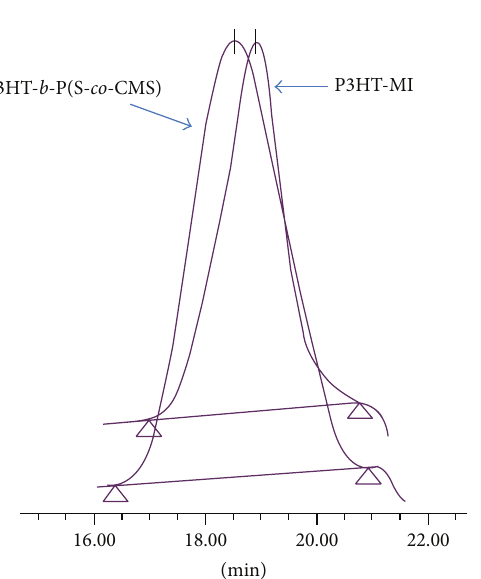
Figure 3: Overlaid GPC chromatograms of the P3HT macroinitia- tor and that of the product obtained from